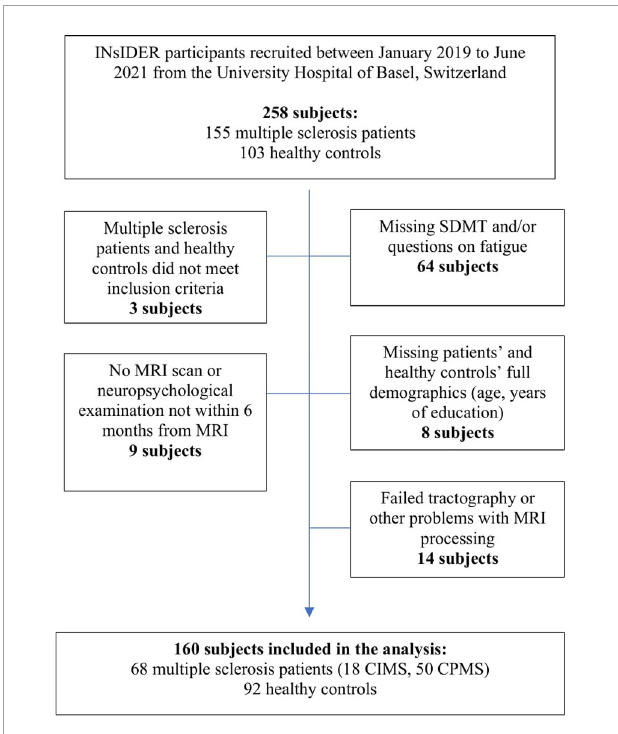
FIGURE1 Consort flow diagram of participants who met inclusion and exclusion criteria. In total 160 subjects were included in the analysis, 68 were patients with multiple sclerosis (pwMS), and 92 healthy controls (HC).